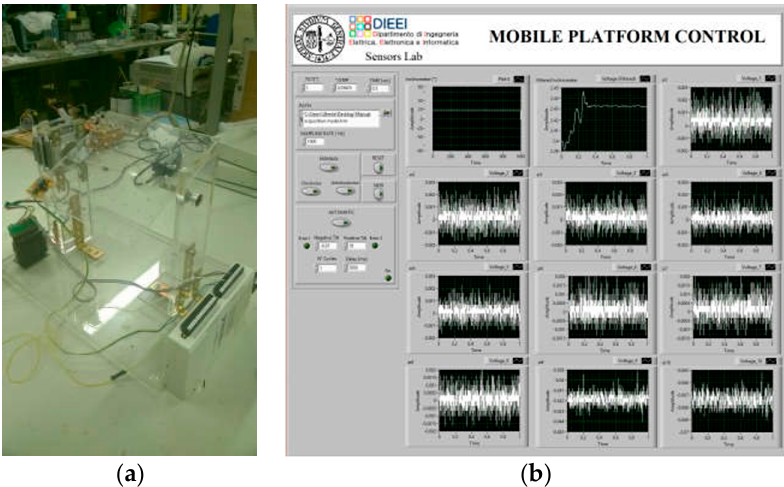
Figure 3. ( a ) The dedicated characterization platform; ( b ) the LabVIEW GUI used to force increasing tilt to the ferrofluid inclinometer and data acquisition through a DAQ